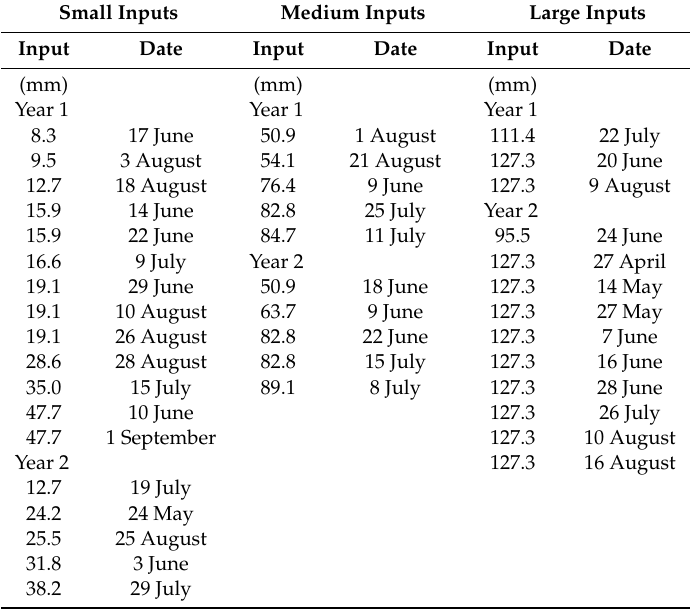
Table 2. Stormwater applications (mm) applied over two years of monitoring. Input data were separated into three size classes: small (8–50 mm), medium (51–90 mm), and large (91–130